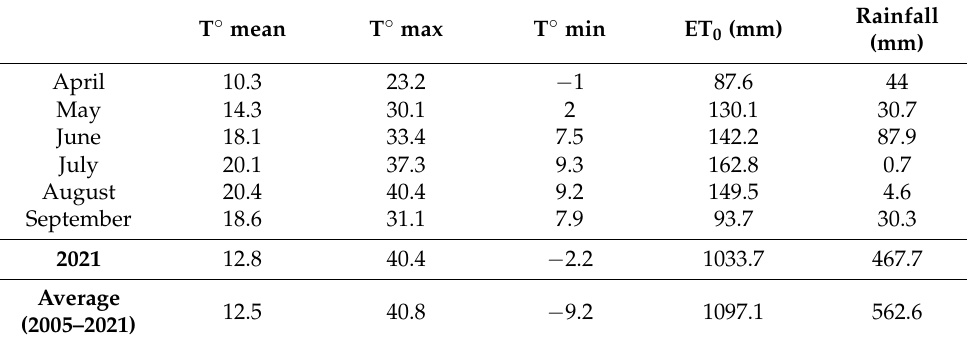
Table 1. Monthly climatic conditions measured during the experimental period in 2021. Values represented are mean temperature (T ◦ mean, ◦ C), maximum temperature (T ◦ max, ◦ C), minimum temperature (T ◦ min, ◦ C), reference evapotranspiration (ET 0 , mm) and rainfall (mm) per month. Climatic balance for the experimental season in 2021 and the average for the 2005–2021 period (from harvest to harvest) are also shown.